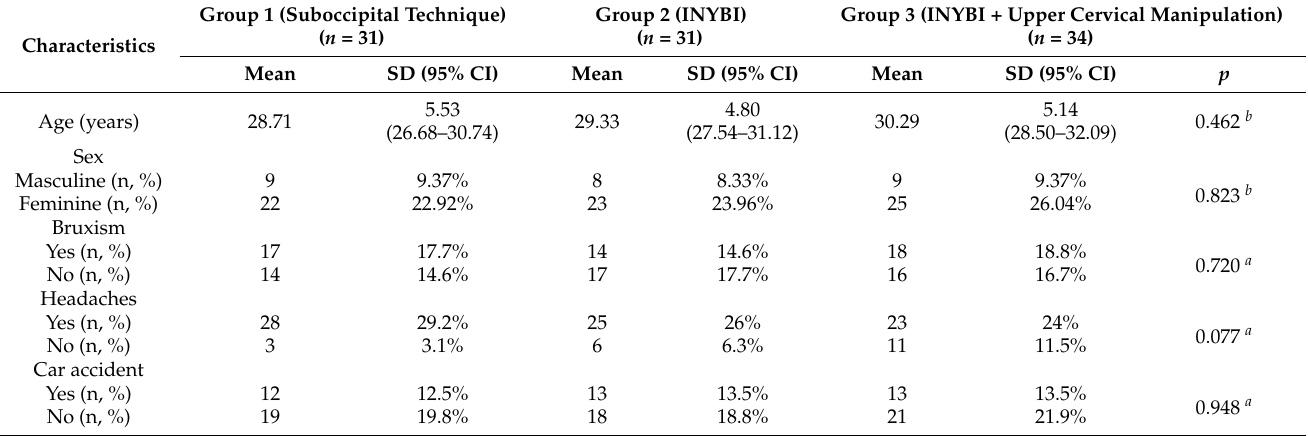
Table 1. Baseline Characteristics of the